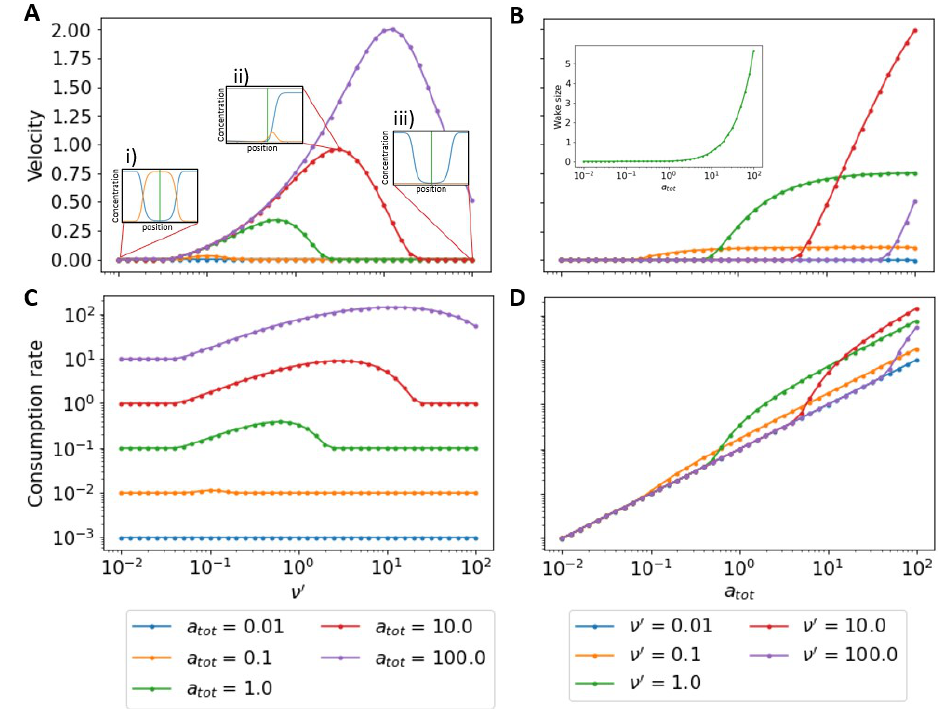
Figure 3. Dependence of steady-state velocity and consumption rate on system parameters. ( A ) Steady-state velocity as a function of ν (cid:48) at different values of a tot . At fixed a tot there is an optimal ν (cid:48) that leads to the largest hub speed. ( B ) Steady-state velocity as a function of a tot at different ν (cid:48) . At fixed ν (cid:48) , the steady-state velocity increases with a tot , but eventually saturates. ( C ) Steady-state substrate consumption rate as a function of ν (cid:48) at fixed a tot . As with velocity, the consumption rate peaks at a given burn rate. ( D ) Steady-state consumption rate as a function of a tot for fixed ν (cid:48) . At a fixed burn rate, the consumption rate increases without bounds with increasing a tot . In all of the = K = above calculations, ω (cid:48) = 0, k (cid:48) of f